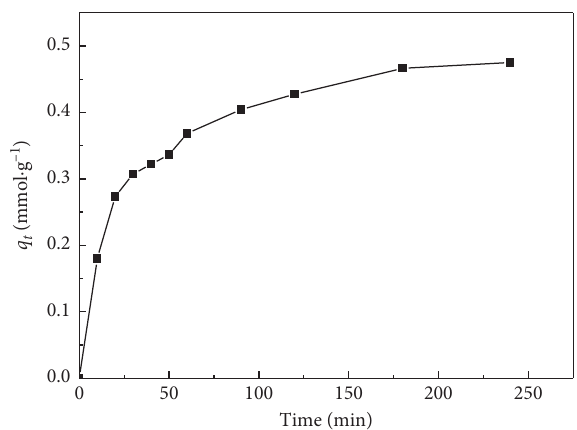
Figure 6: Effects of adsorption time onto Mn/AC (model oil DM0, 20mL; DBT, 9.38mmol · L − 1 ; adsorbents, 0.2g 2wt. % Mn/AC; adsorptive temperature, 313K).